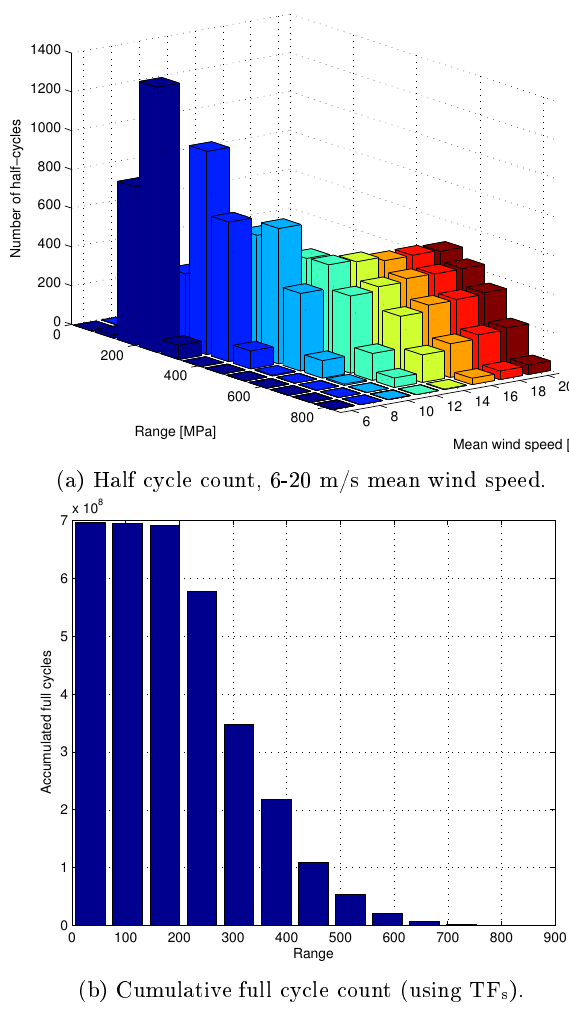
Figure 14: Example of rain (cid:29)ow counting result using TI=10%.